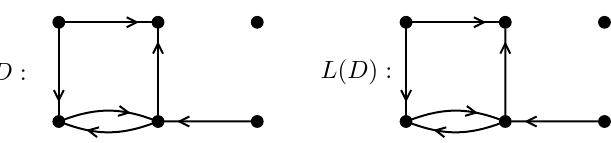
Figure 17: A disconnected digraph isomorphic to its line